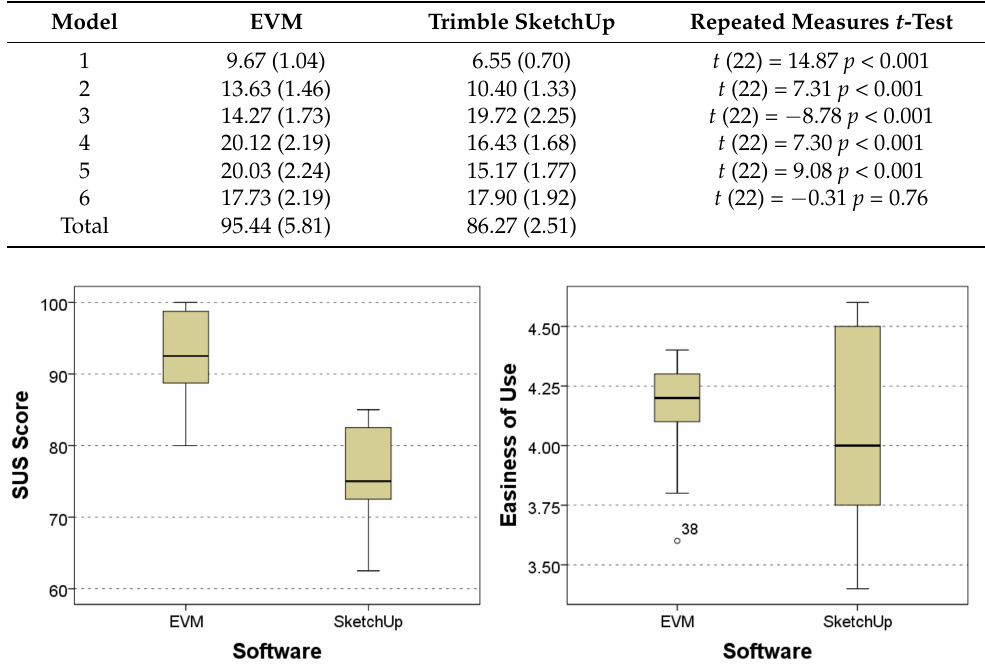
Figure 10. Boxplots for SUS and ease of use scores.